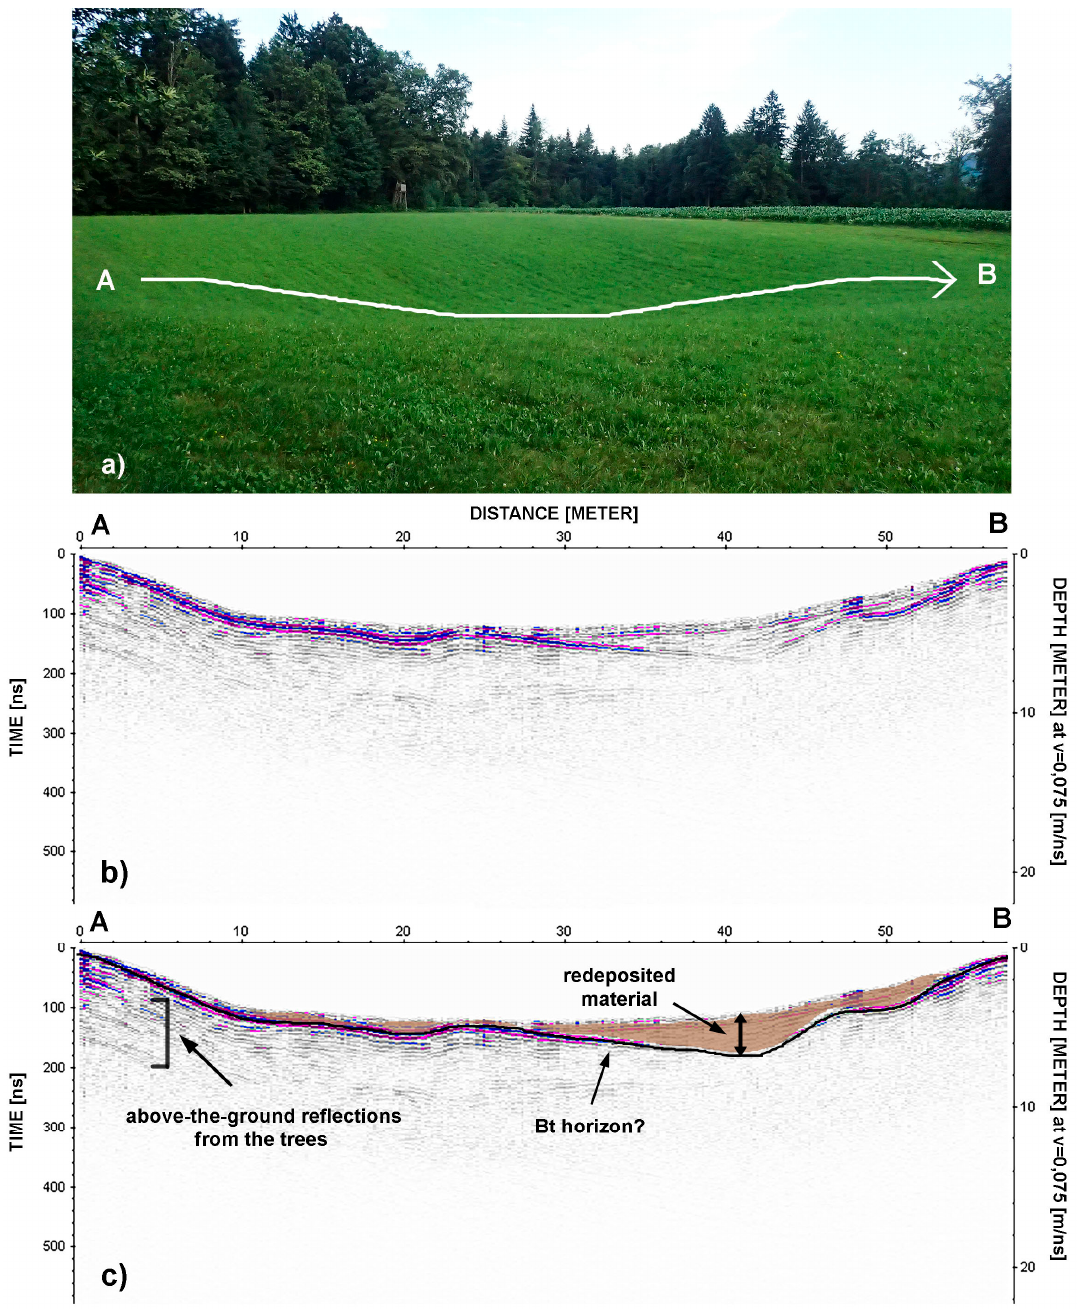
Figure 5. ( a ) The direction of Profile 2 acquired over a cultivated doline on middle conglomerate (Dobrava); ( b ) A processed and topographically corrected radargram; ( c ) An interpreted